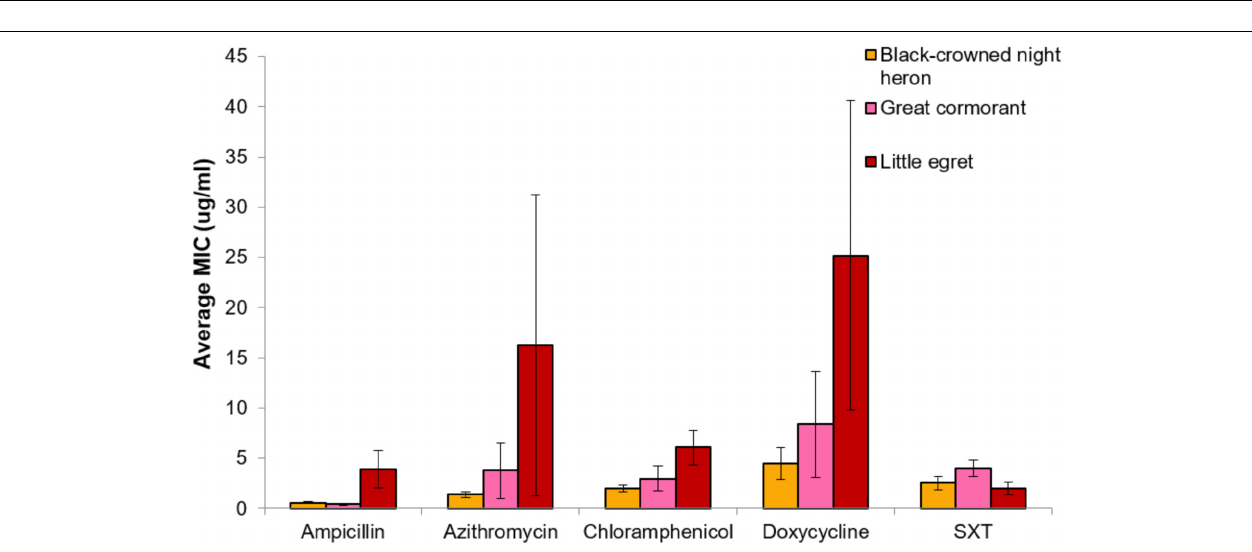
FIGURE 4 | Comparative analysis of MIC (average ± std. error) for each of the studied antimicrobial agents toward V. cholerae strains that were isolated from the three waterfowl species [black-crowned night herons (orange, n = 21), great cormorants (pink, n = 5), and little egrets (red, n = 22)]. No significant differences were found between MIC concentrations of the different strains that were isolated from different waterfowl species ( p > 0.05).